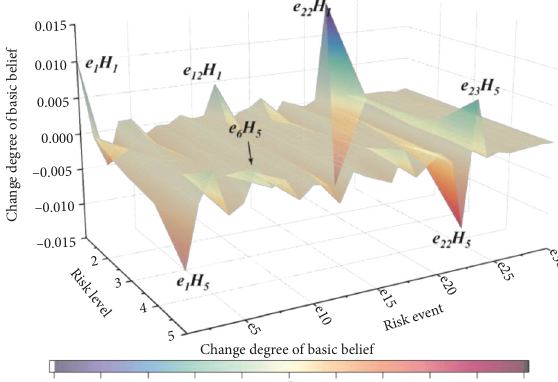
Figure 12: Changes of basic belief of each risk event on the overall risk before and after considering the weight of loss